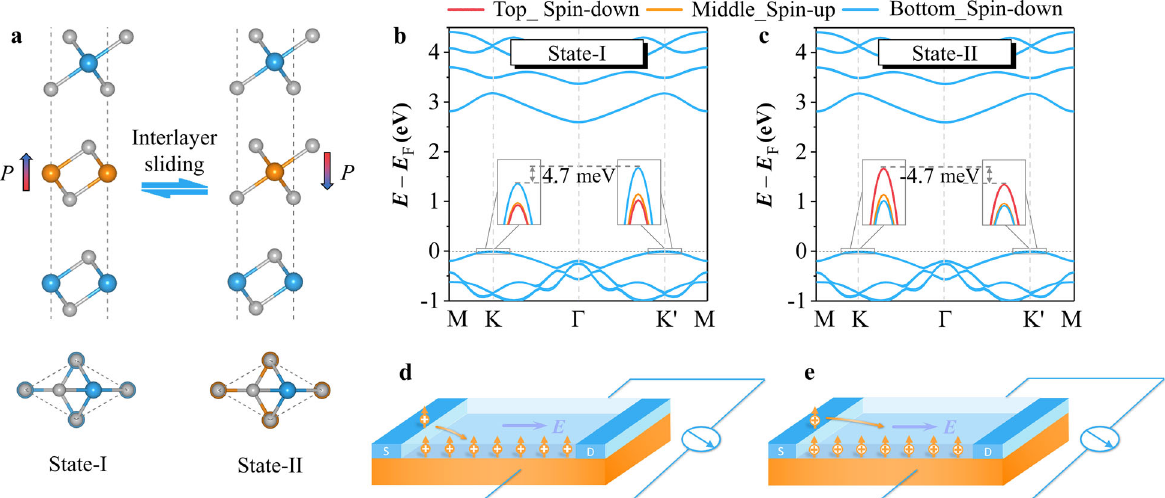
Fig. 4 Crystal structures, band structures, and anomalous valley Hall effect of triple-layer T-FeCl 2 . a Crystal structures triple-layer T-FeCl 2 under state-I and state-II. Band structures of b state-I and c state-II of triple-layer T-FeCl 2 with considering SOC. Insets in b , c show the enlarged bands around the valleys. The Fermi level is set to 0 eV. Diagrams of the anomalous valley Hall effect under hole doping for d state-I and e state-II. The holes from the K and K ′ valleys are denoted by orange + and white + symbols, respectively. Upward arrows refer to the spin-up